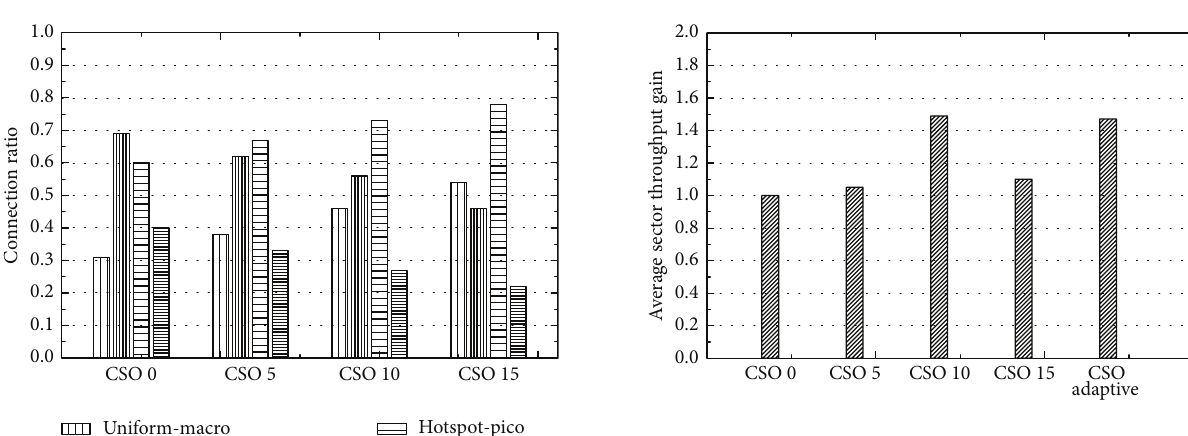
Figure 8: Average sector throughput gain in hotspot